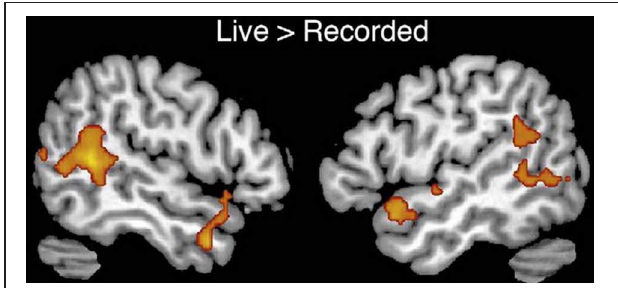
FIGURE 1 | From Redcay et al. (2010) top panel; regions responding more to live interaction with a person than a recorded interaction (note activity is bilateral). Reprinted Figure 2, top panel from Redcay et al. (2010), Copyright (2010) used with permission from